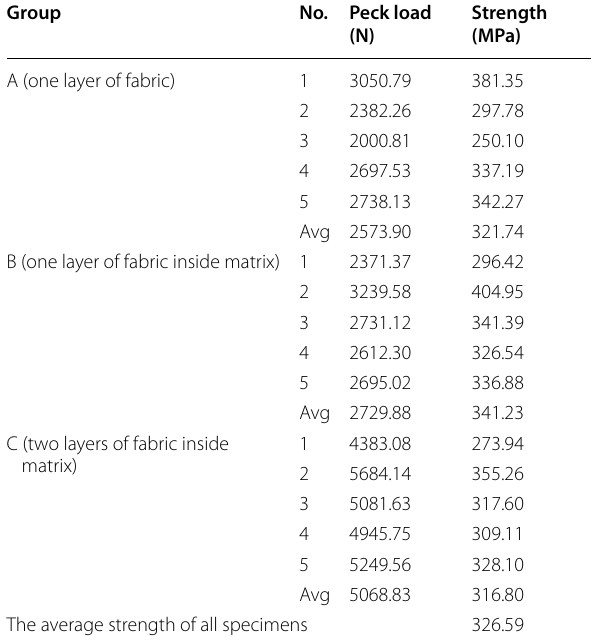
Table 3 Strength calculation of all direct tensile tests Group